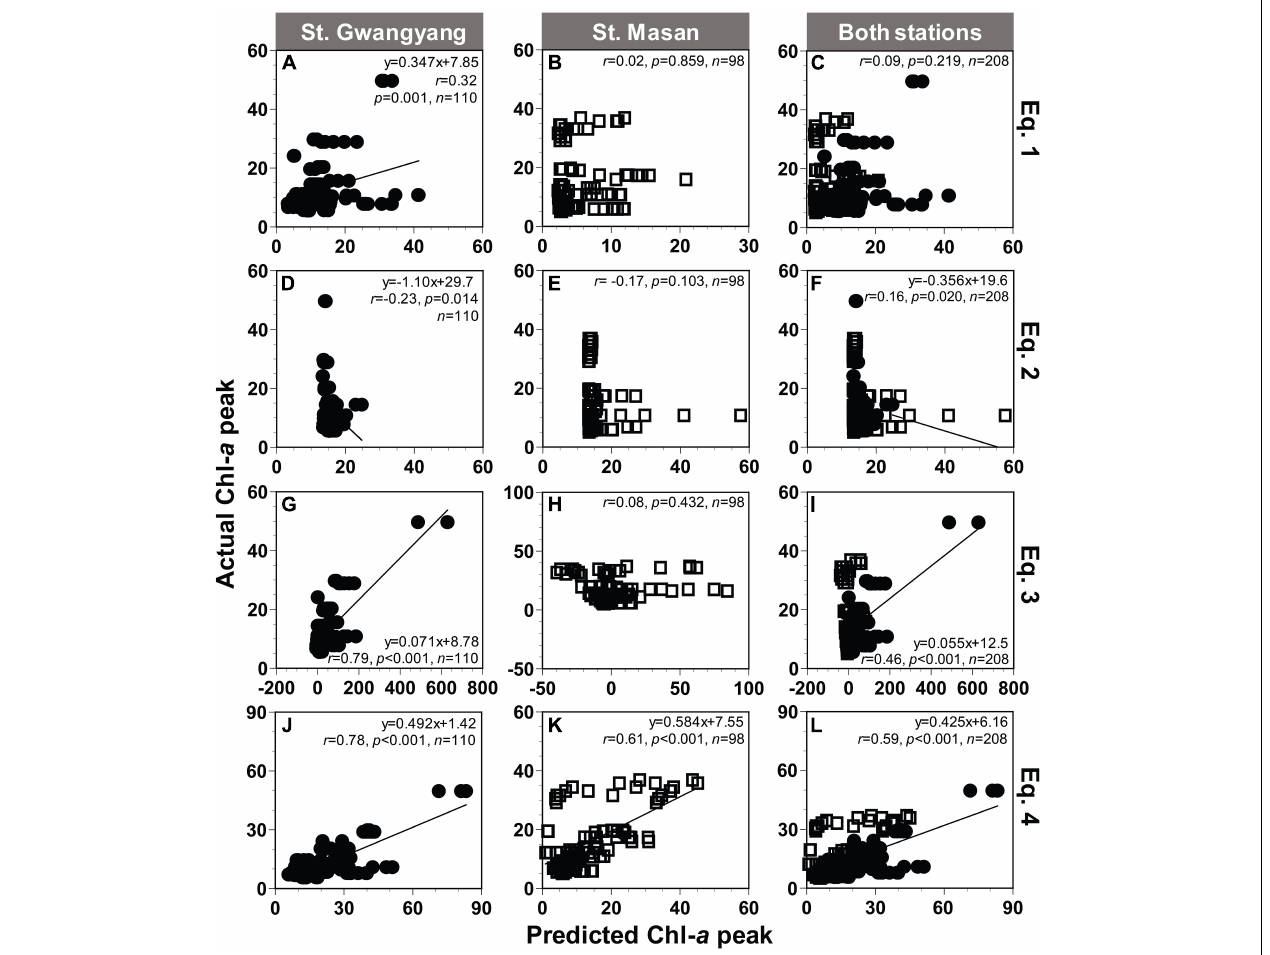
FIGURE 8 | Comparison between the actual and predicted values of the Chl- a peak ( µ g L − 1 ) at St. Gwangyang (closed circle), St. Masan (open square), and both stations. The predicted Chl- a peak values calculated using concentrations of NO 3 and Chl- a at each station and Eq. 1 (A–C) , Eq. 2 (D–F) , Eq. 3 (G–I) , and Eq. 4 (J–L) in Table 2